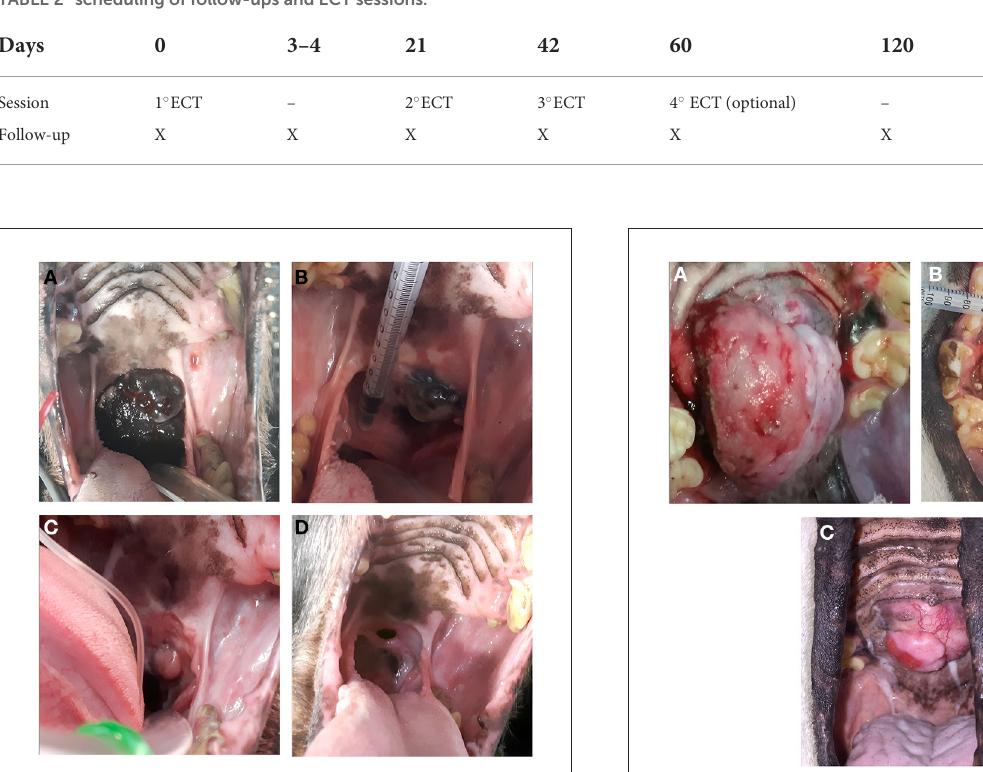
FIGURE2 Case n 5, a dog with oral malignant melanoma before the ECT treatment (A) , after the first electroporation (21 days follow-up) (B) , after the second electroporation (42 days follow-up) (C) and at the end of the treatment (1 month follow-up) showing an oronasal fistula (D) .